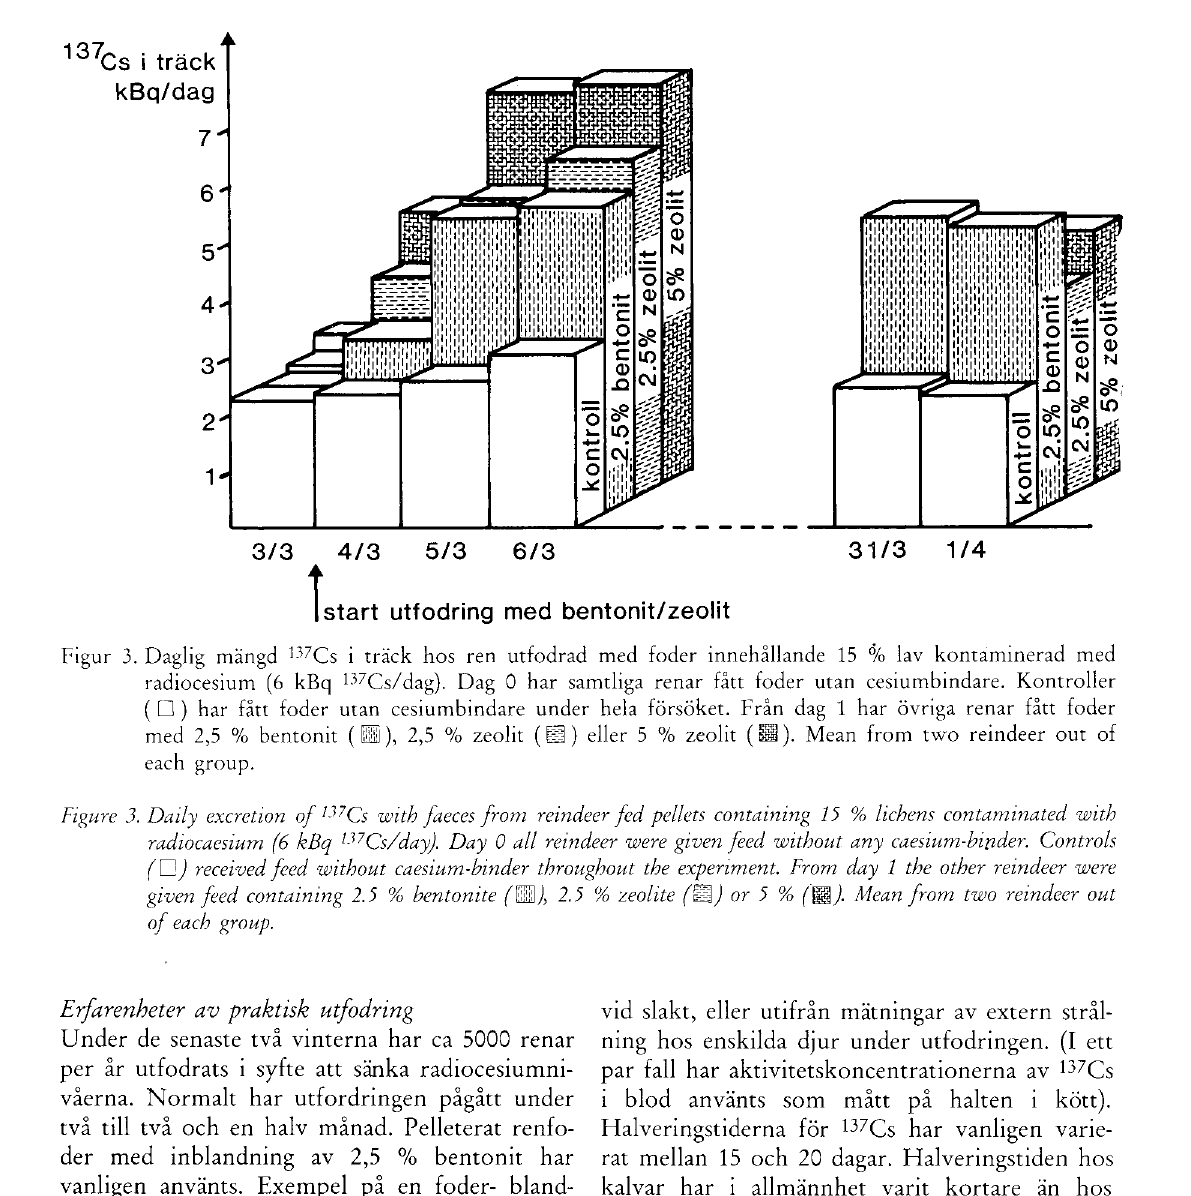
Figure 3. Daily excretion of 137 Cs with faeces from reindeer fed pellets containing 15 % lichens contaminated with radiocaesium (6 kBq L37 Cs/day). Day 0 all reindeer were given feed without any caesium-binder. Controls (^]) received feed without caesium-binder throughout the experiment. From day 1 the other reindeer were given feed containing 2.5 % bentonite (M) 2.5 % zeolite (M) or 5 % (M)- Mean from two reindeer out 3 of each